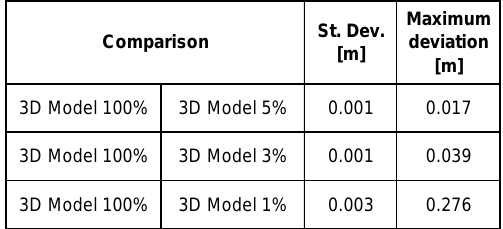
Table 3. Statistical values of the comparison between original 3D Model and resampled